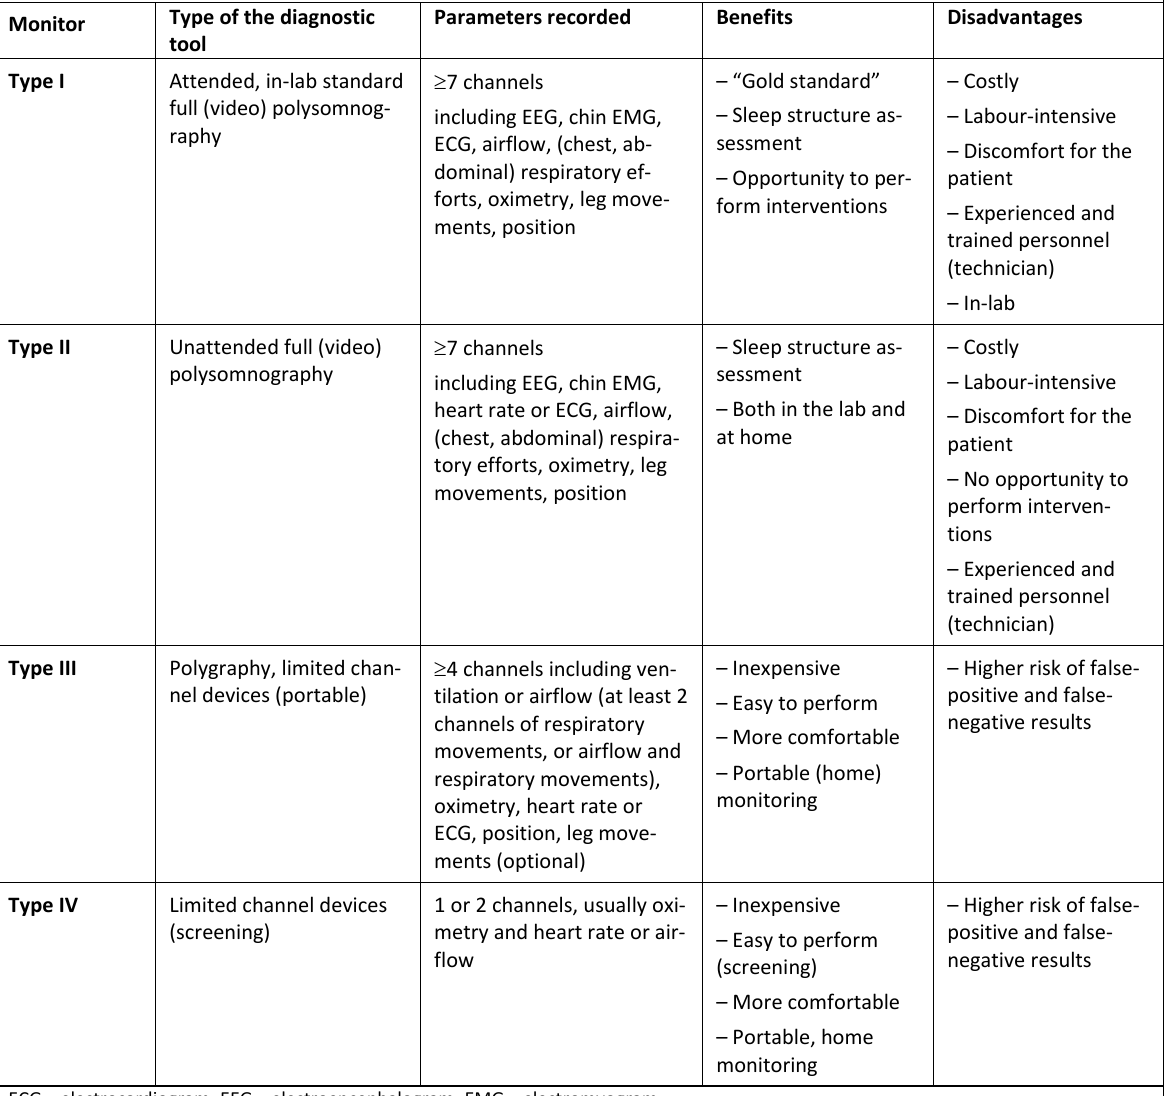
Table 2: Types of diagnostic tool (according to the American Academy of Sleep Medicine classification).